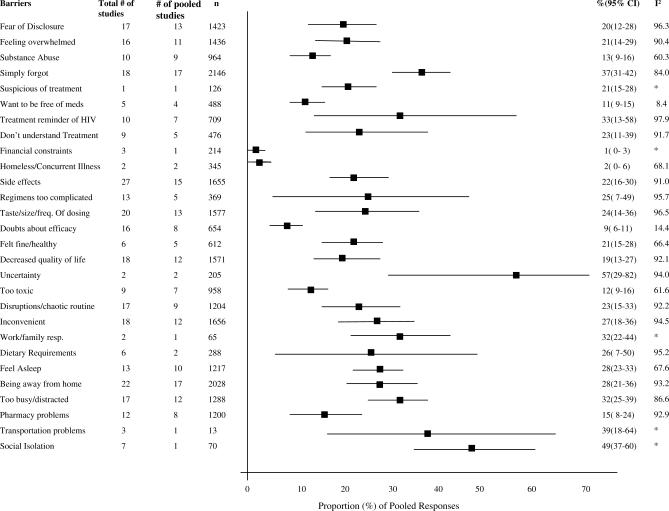
Barriers Reported in Developed Countries